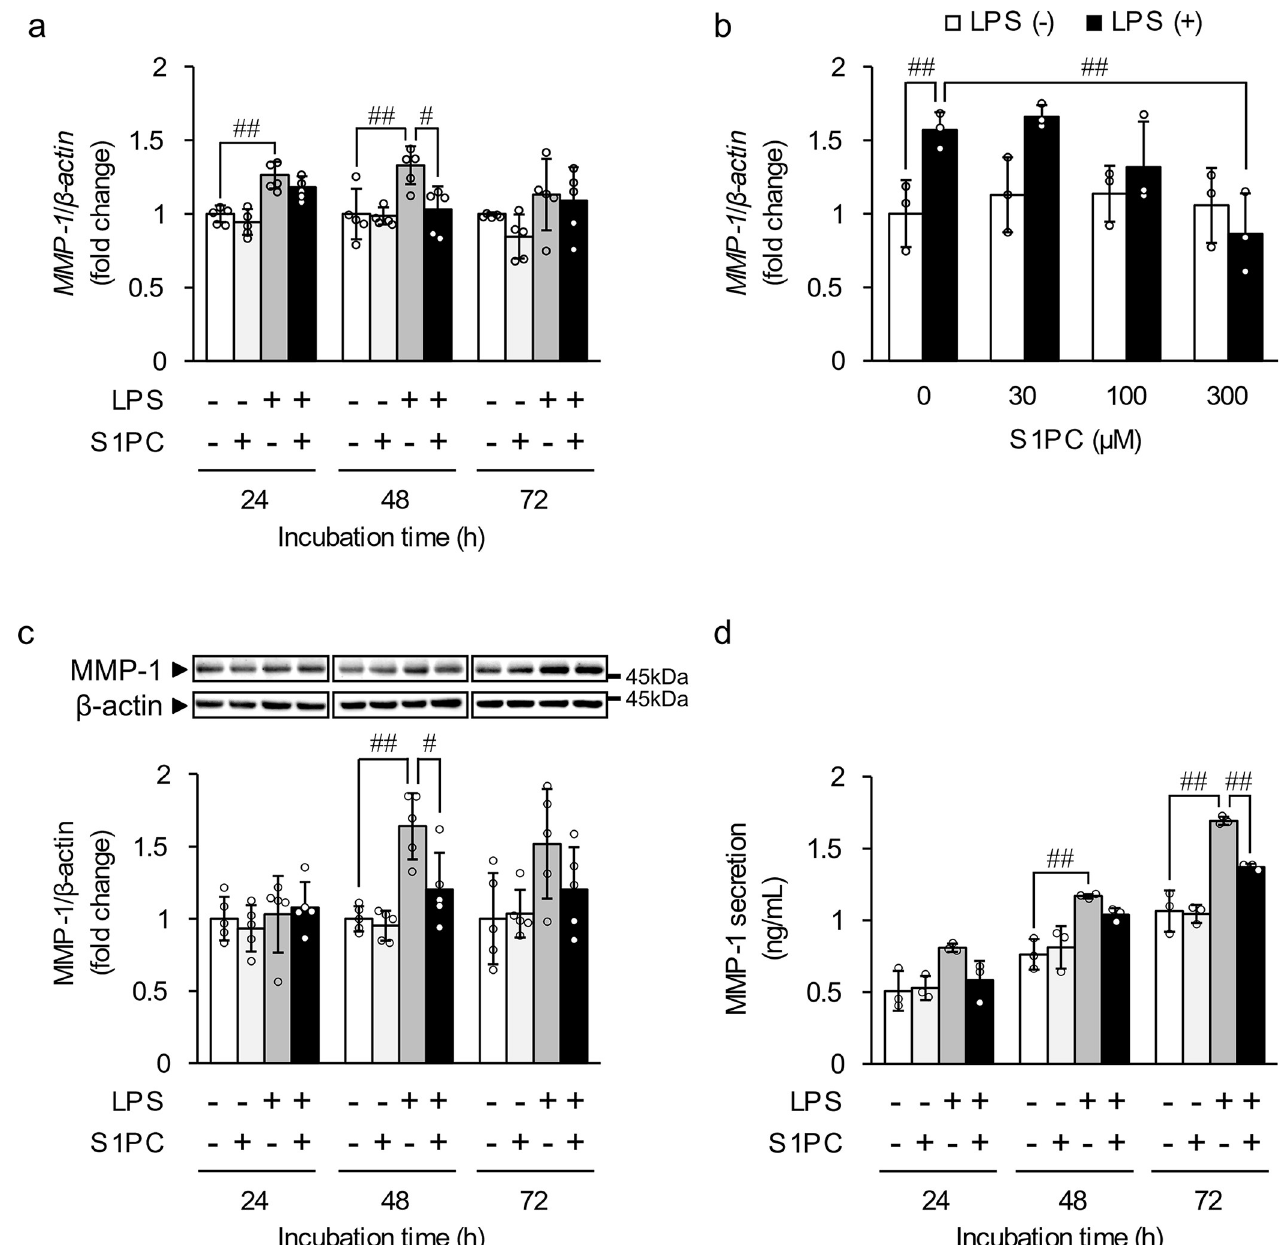
Fig 2. The effect of S1PC on the LPS-induced expression and secretion of MMP-1. ( a ) HGF-1 cells were exposed to S1PC (300 μ M) in the presence or absence of LPS (3 μ g/mL) for the indicated times. Bar graphs show the mRNA level of MMP-1, calculated relative to the level in the vehicle group at each time point. Values represent the mean ± S.D. (n = 5). # p < 0.05, ## p < 0.01. ( b ) HGF-1 cells were exposed to S1PC in the presence or absence of LPS for 48 h at indicated concentrations. The graph shows the mRNA level of MMP-1 . Values represent the mean ± S.D. (n = 3). # p < 0.05, ## p < 0.01. ( c ) HGF-1 cells were exposed to S1PC (300 μ M) in the presence or absence of LPS for the indicated times. Photographs show a representative result of Western blotting of MMP-1 with β -actin as an internal control. The graph shows the ratio of the MMP-1 band intensity relative to that of β -actin. Values represent the mean ± S.D. (n = 5). # p < 0.05, ## p < 0.01. ( d ) HGF-1 cells were exposed to S1PC in the presence or absence of LPS for 72 h. The graph shows the concentration of MMP-1 in media determined by ELISA normalized to the total cell protein amount in each treatment group. Values represent the mean ± S.D. (n = 3). ## p < 0.01.